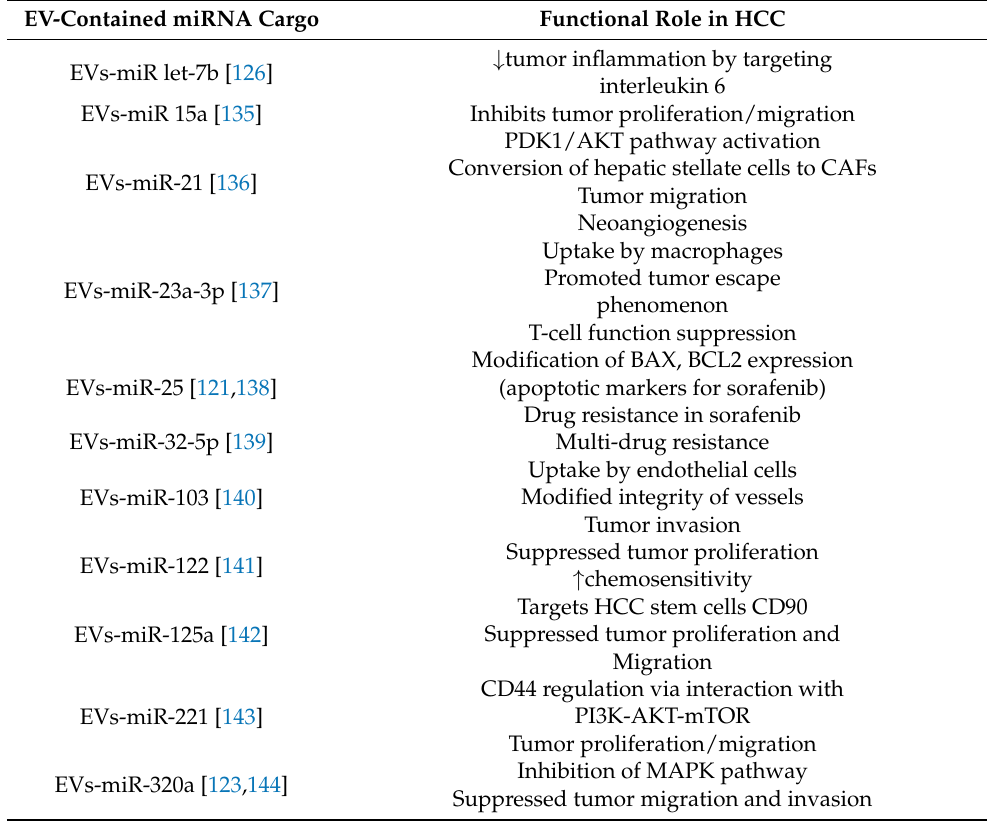
Table 5. EV-contained miRNA cargoes and their functional role in